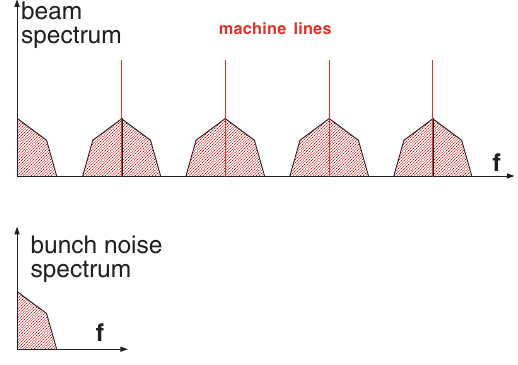
FIG. 1. (Color) Sketch of primary bunch-noise spectrum (bot- tom) and the beam spectrum as seen by the HOMs (top) for flat beam pulses (no pulse chopping).